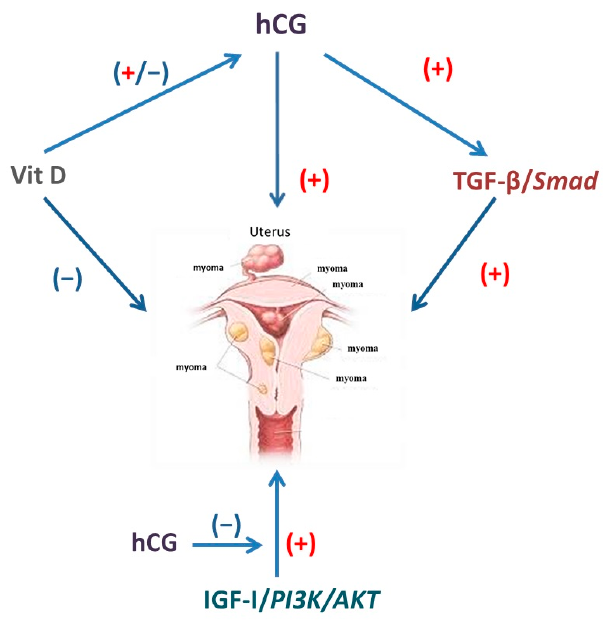
Figure 3. Potential mechanisms of hCG action on leiomyomal cells. hCG: (I) may activate the TGF- β /Smad pathway; (II) may interact with the Vitamin D signaling; and (III) may affect the IGF-I-induced cell proliferation. hCG: human chorionic gonadotropin; Vit D: vitamin D; TGF- β : transforming growth factor- β ; IGF-I: insulin growth factor I.